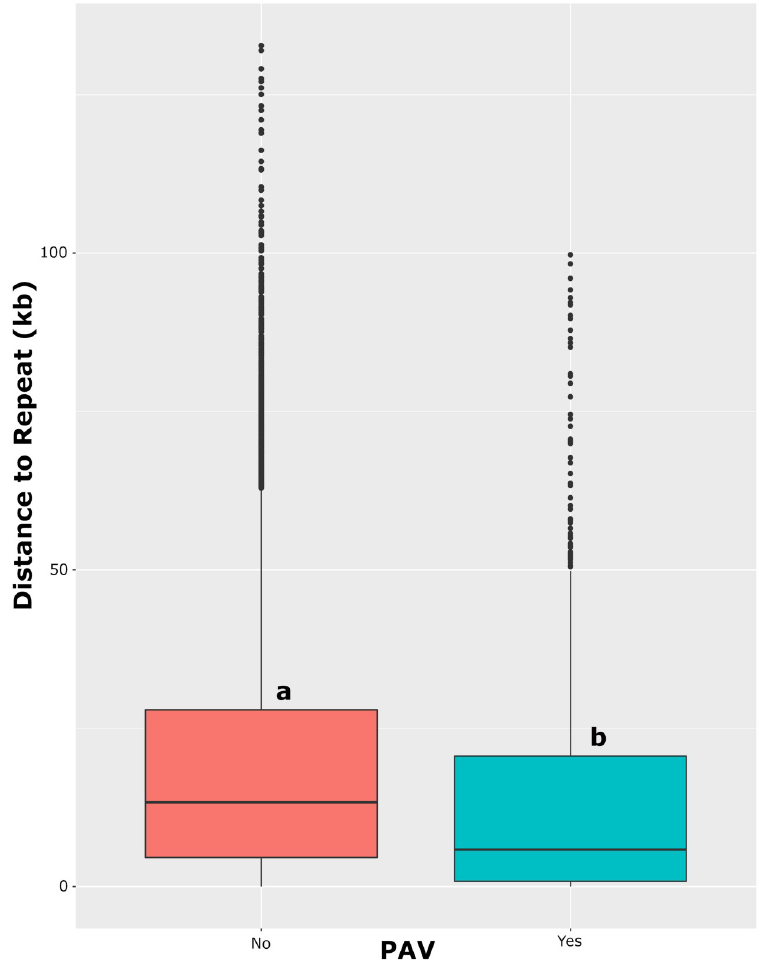
Fig 8. Distances of genes to the nearest repetitive element. Categories are listed on the x-axis and distance to nearest repeat on the y-axis. Different letter codes (a and b) correspond to statistically different groups (Kruskal-Wallis rank sum test p <